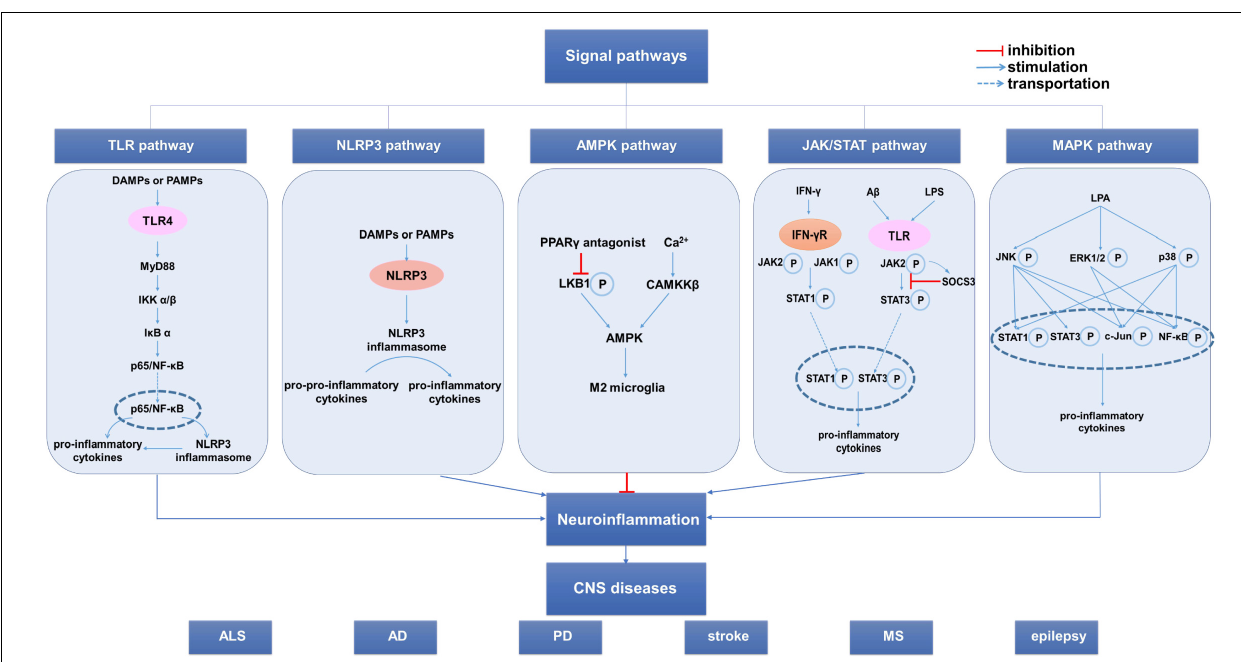
FIGURE 3 | The signal pathways involved in the microglia phenotypic transition. Several signal pathways are involved in the regulation of the microglia phenotypic transformation, mainly including the TLR4/NF- κ B pathway, NLR pathway and JAK/STAT pathway. Additionally, AMPK pathway and MAPK pathway can also affect the microglia phenotypic transition. These pathways influence neuroinflammation by regulating the microglia phenotypic transition, thus influencing the occurrence, development, and prognosis of CNS diseases. AD, Alzheimer’s disease; ALS, amyotrophic lateral sclerosis; CNS, central nervous system; MS, multiple sclerosis; NLR, NOD-like receptor; PD, Parkinson’s disease; SOCS3, suppressor of cytokine signaling 3; TLR, Toll-like